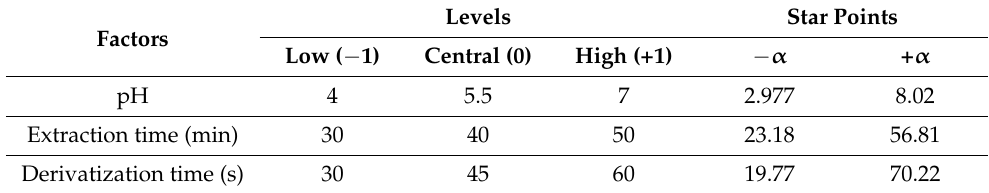
Table 2. Significant factors and their levels studied by CCD.